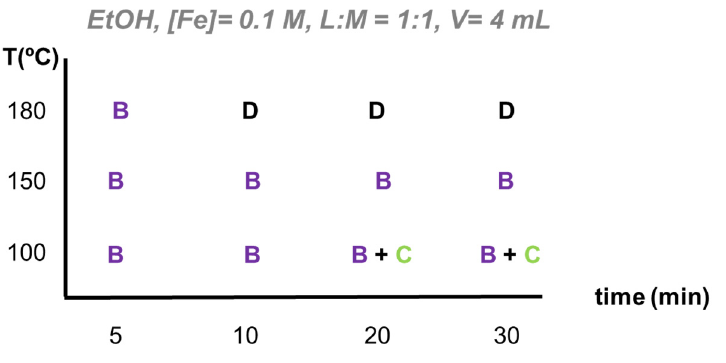
Figure 2. Crystallization diagram for the MW-assisted solvothermal synthesis of the system FeCl 3 / H 2 BDC-NH 2 in EtOH based on PXRD data. Legend: A = to MIL-53-NH 2 , B = to MIL-88B-NH 2 , C = to MIL-101-NH 2 , D = Fe 2 O 3 .